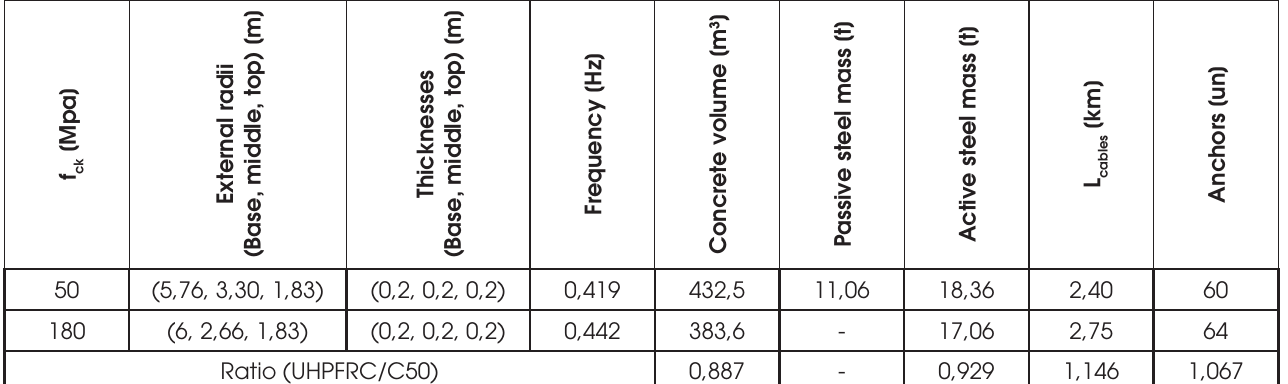
Table 4 Low cost towers of UHPFRC and C50